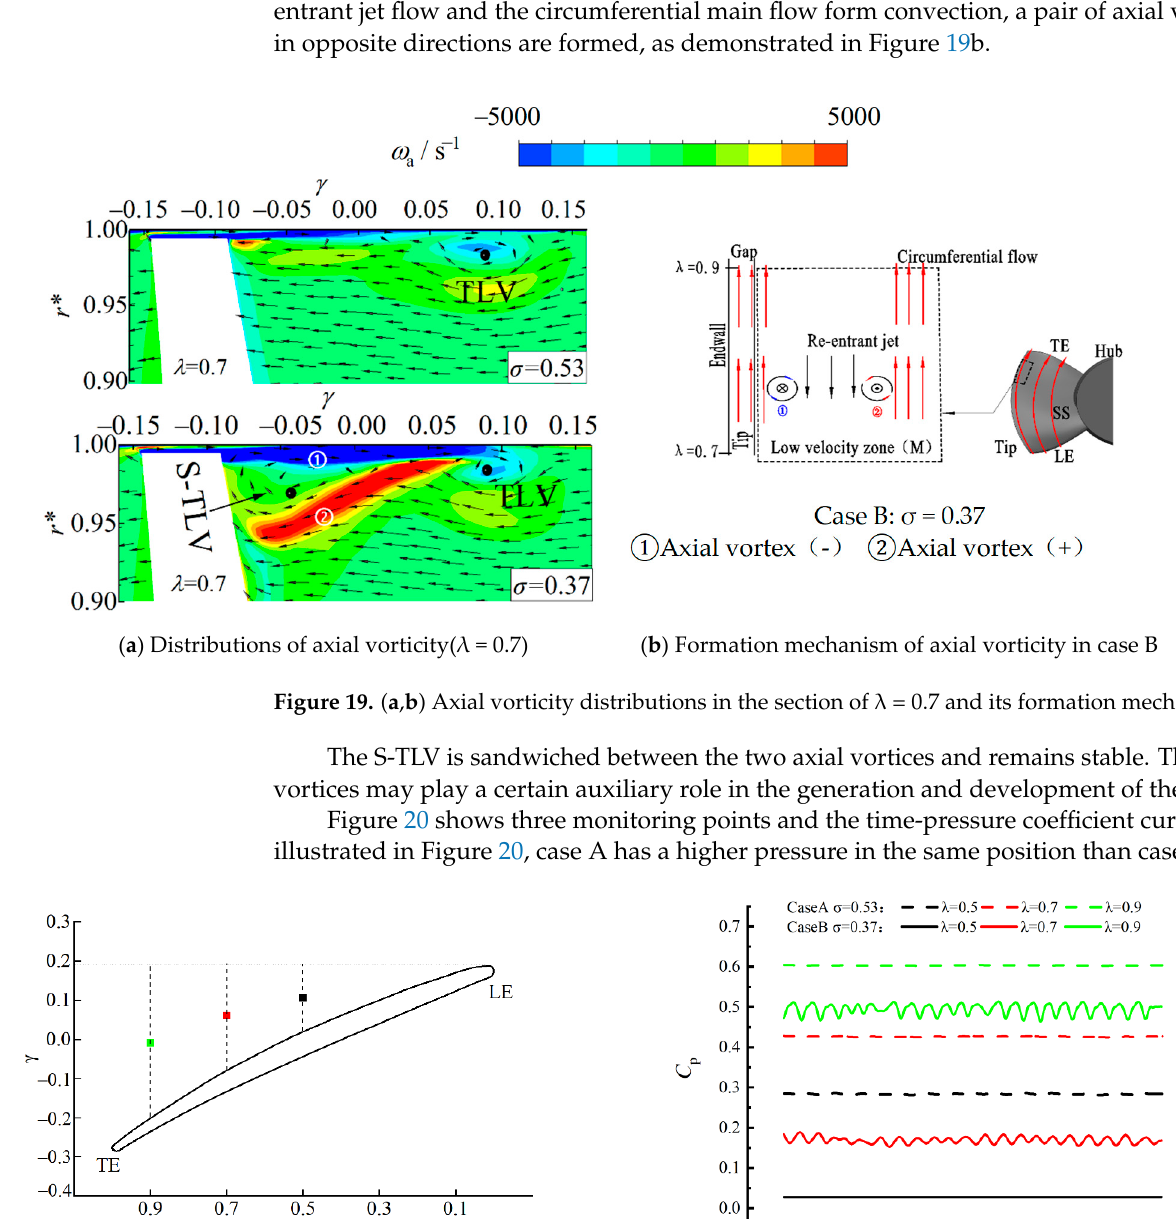
Figure 19. ( a , b ) Axial vorticity distributions in the section of λ = 0.7 and its formation mechanism.